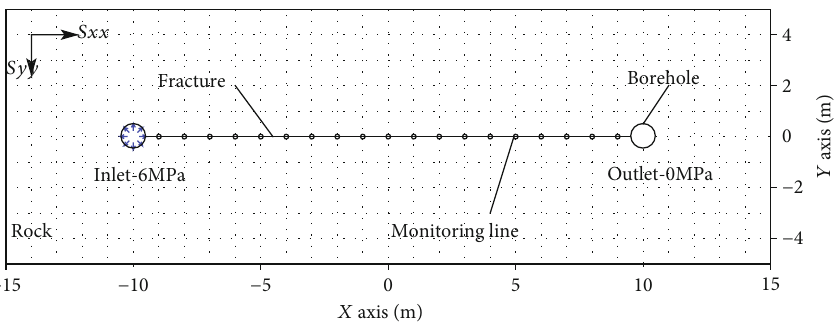
Figure 6: Single fracture fl uid fl ow test.